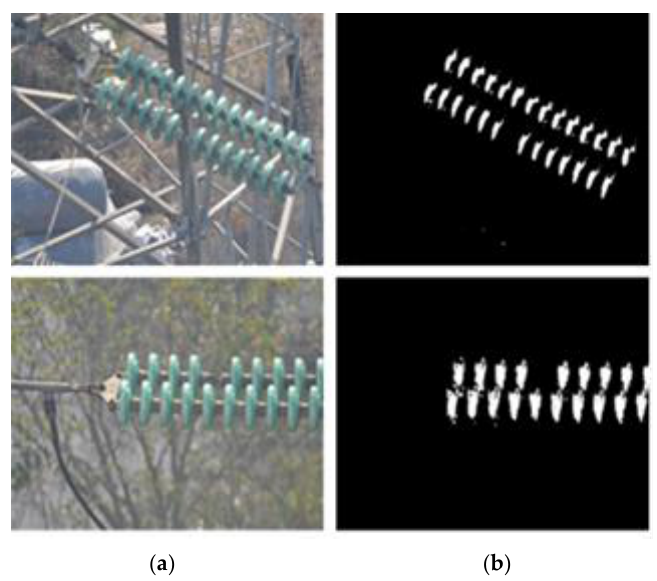
Figure 2. Results of segmentation: ( a ) Original aerial images; ( b ) Segmentation results.